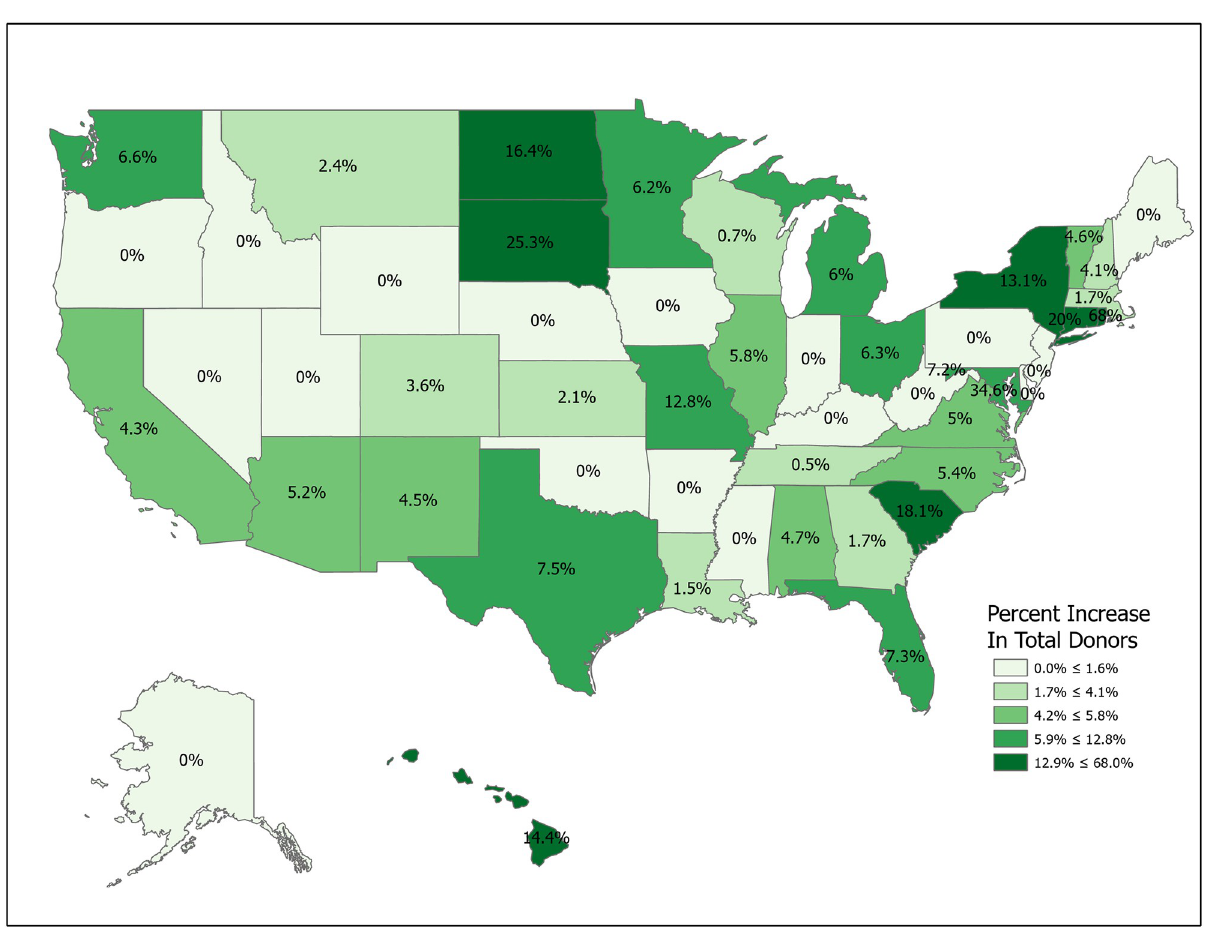
Fig 14. Simulation 8: Raise Non-registered donor authorization rate ( q 2 ) to Minimum of 0.6. Data come from Table 6. Maps created by ArcGIS Pro, URL: https://www.esri.com/en-us/arcgis/products/arcgis-pro/overview. Base Map: World Light Gray Base, URL: https://services.arcgisonline.com/